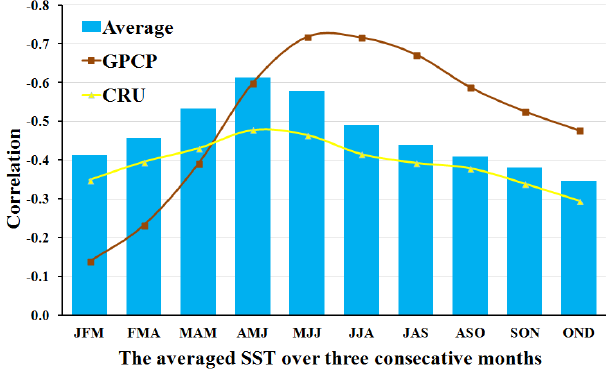
Figure 10. Correlation between rainfall anomalies over the Ethiopian Highlands (Reg-TB ensemble average, GPCP and CRU) and SST anomalies over the Pacific Ocean in the Niño 3.4 region.